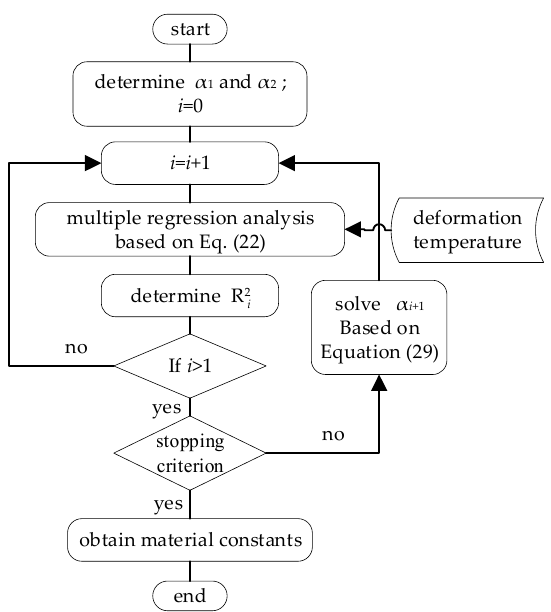
Figure 8. Process of solving material constants in the modified strain-compensated Arrhenius-type (msA)-type equation by combining multiple regression analysis with a linear